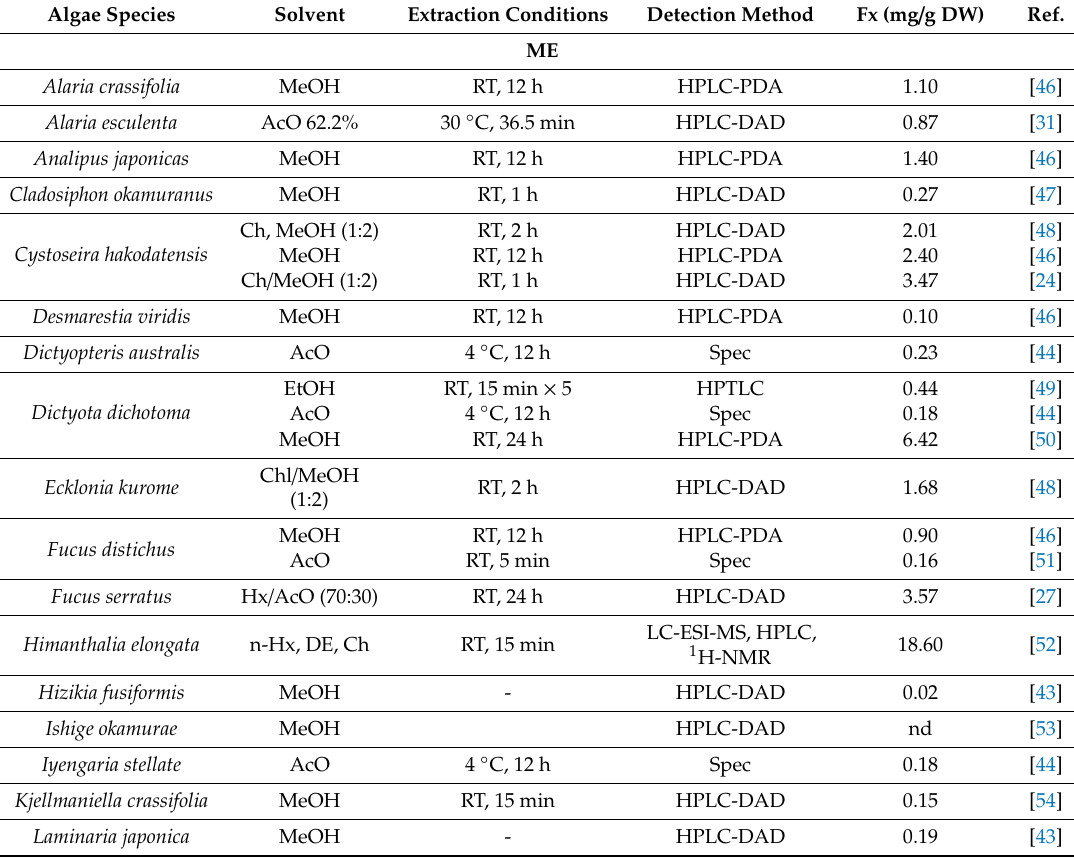
Table 1. Brown algae species described as a source of fucoxanthin extracted by conventional extraction techniques, detection methods employed for determining its presence and quantification values (fucoxanthin concentration are expressed in fucoxanthin (Fx) mg / g of DW, or where not determined, “nd” was